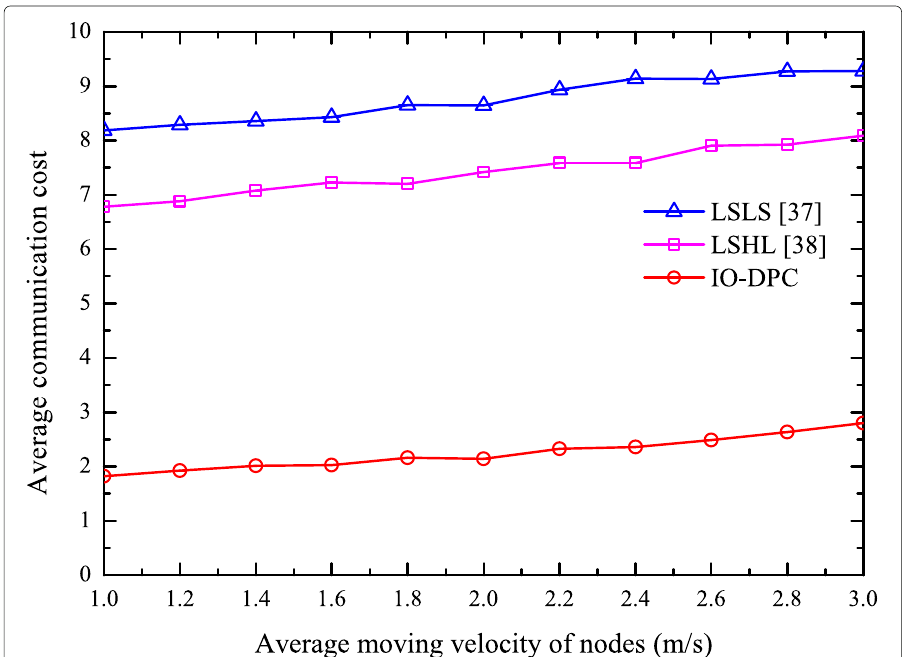
Fig. 12 Comparison of average communication cost between IO-DPC and the other two technologies